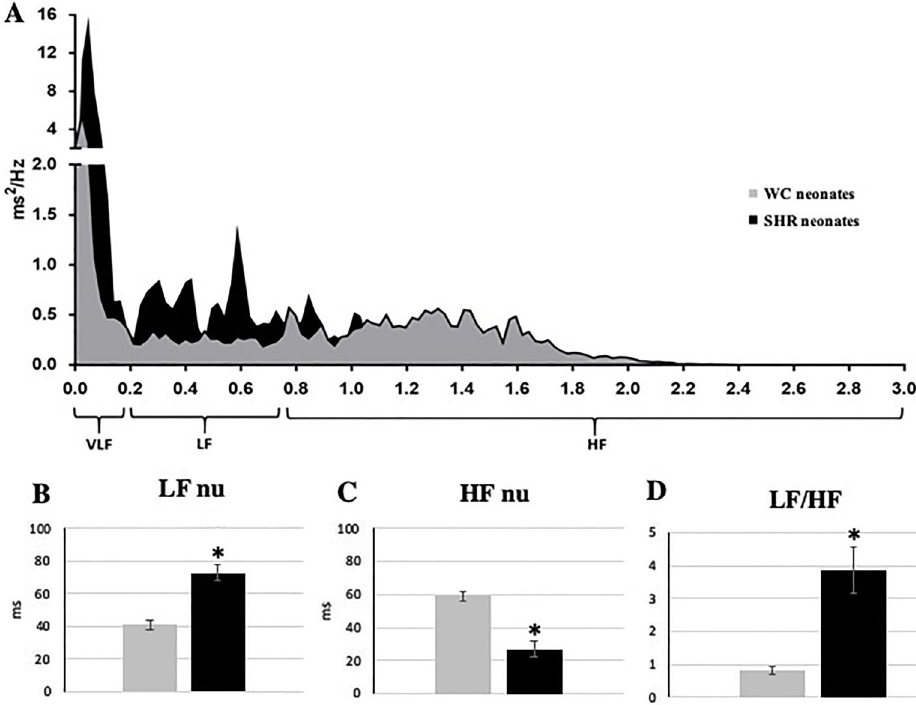
Figure 2. A , Power spectrums of Wistar control (WC) and spontaneously hypertensive rat (SHR) neonates. B, Low frequency (LF) band of RR interval in normalized units (nu). C , High frequency (HF) band of RR interval in nu, D , LF/HF ratio. VLF: very low frequency band. Data are reported as means ± SE. *P o 0.05 vs WC neonates (Student ’ s t -test).